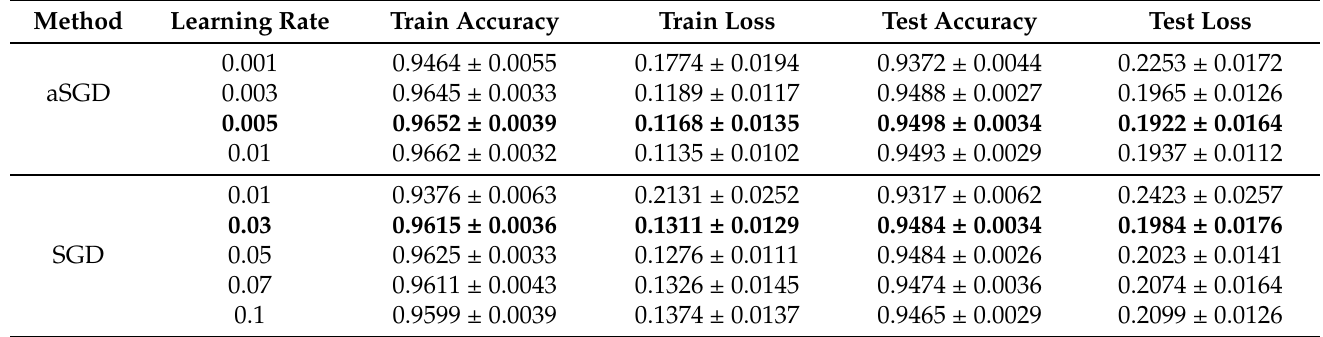
Table 2. The mean and variance of the model performance trained on MNIST images at suitable learning